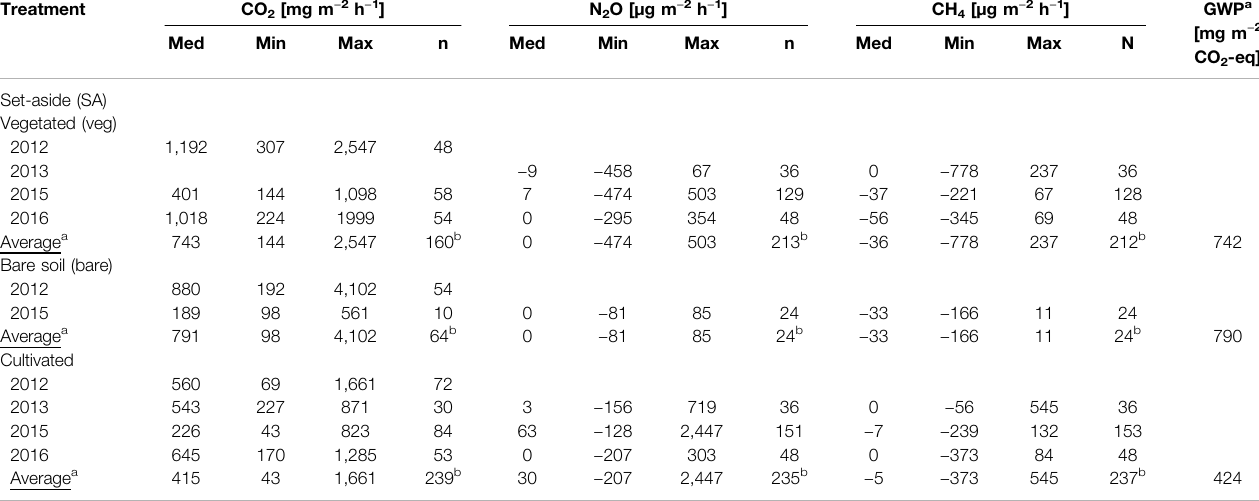
a Median over the study period. b Total number of data points.